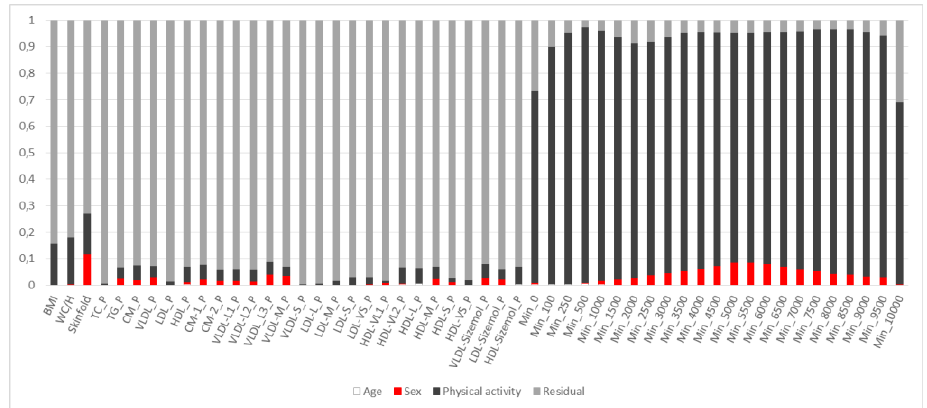
Figure A2. Variance plot displaying explained variance of the covariates sex, age, and physical activity. Repeated Monte-Carlo validation implied four principal components with predictive in- formation, explaining respectively 63.3, 16.5, 8.6, and 4.5% of the total variance in the 23 physical activity variables. These four principal components were used as covariates representing the physical activity descriptor. For the physical activity variables, the names imply the lowest intensity levels in each intensity interval defined in Section 2.3. For instance, the name Min_0 implies the intensity interval 0–99 cpm.